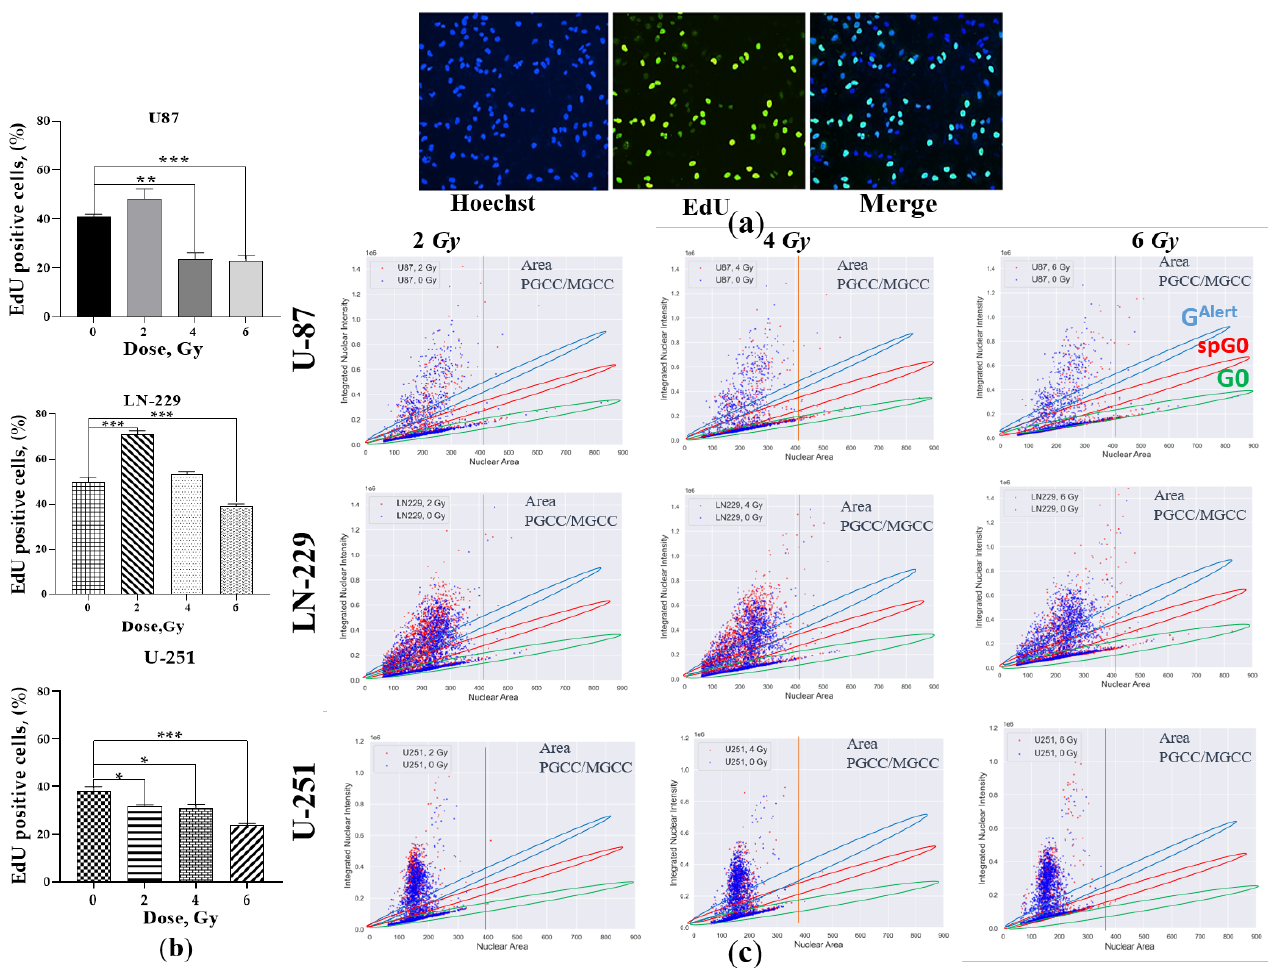
Figure 4. EdU-coupled fluorescence intensity analysis. ( a ) Representative immunofluorescence images of cell nuclei (Hoechst 33,342 (blue), EdU incorporated into DNA (green), and merged images). ( b ) The percentage of EdU-positive GBM cells. ( c ) High-content imaging and analysis of EdU-coupled fluorescence of control (blue dots) and irradiated (red dots) GBM cells at 24 h after exposure to different doses of X-rays rays (cells were seeded in a 96-well plate at a concentration of 2 × 10 3 cells/0.32 cm 2 ). PGCC area denotes the nuclear area threshold to delineate PGCCs/MGCCs of each cell line. The color segmentation of different populations (G Alert , spG0 and G0). Data are means ± SEM of three independent experiments. * p ≤ 0.05, ** p ≤ 0.01, *** p ≤